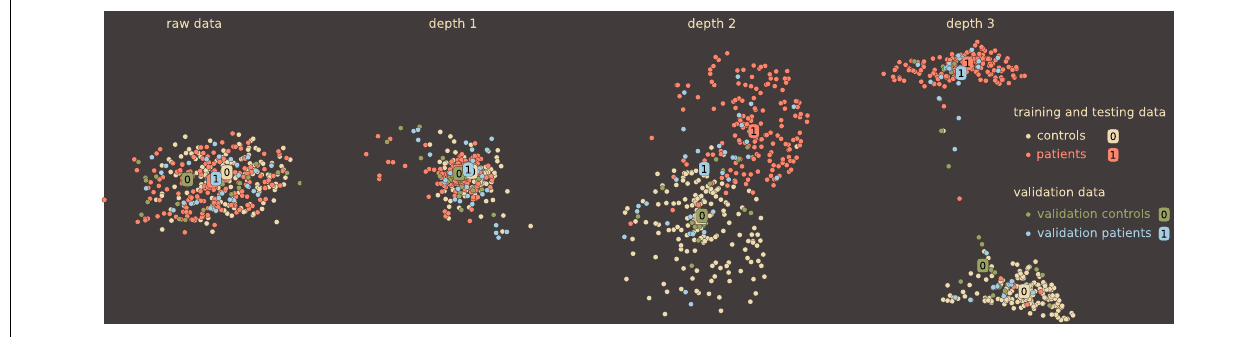
subjects) from validation (54 subjects) data. Although the data becomes separable at depth 1 and more so at depth 2, the DBN continues distilling details that pull the classes further apart.